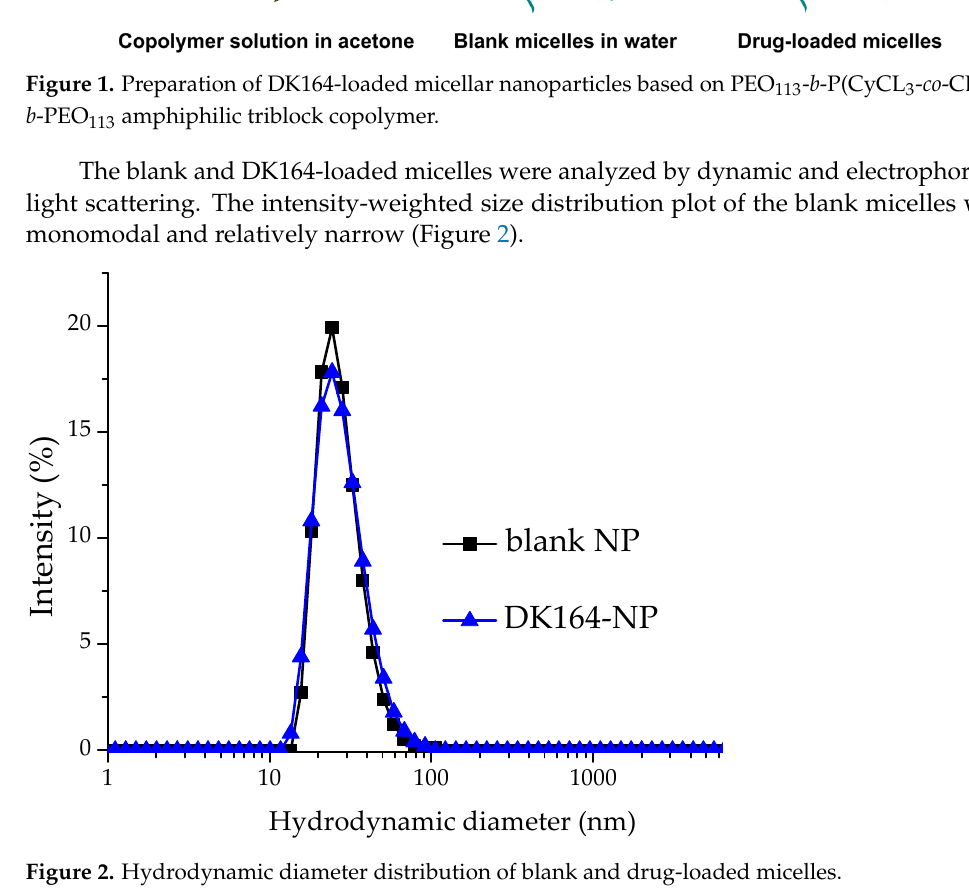
Table 1. Physicochemical characteristics of blank and DK164-loaded micelles prepared from PEO 113 -